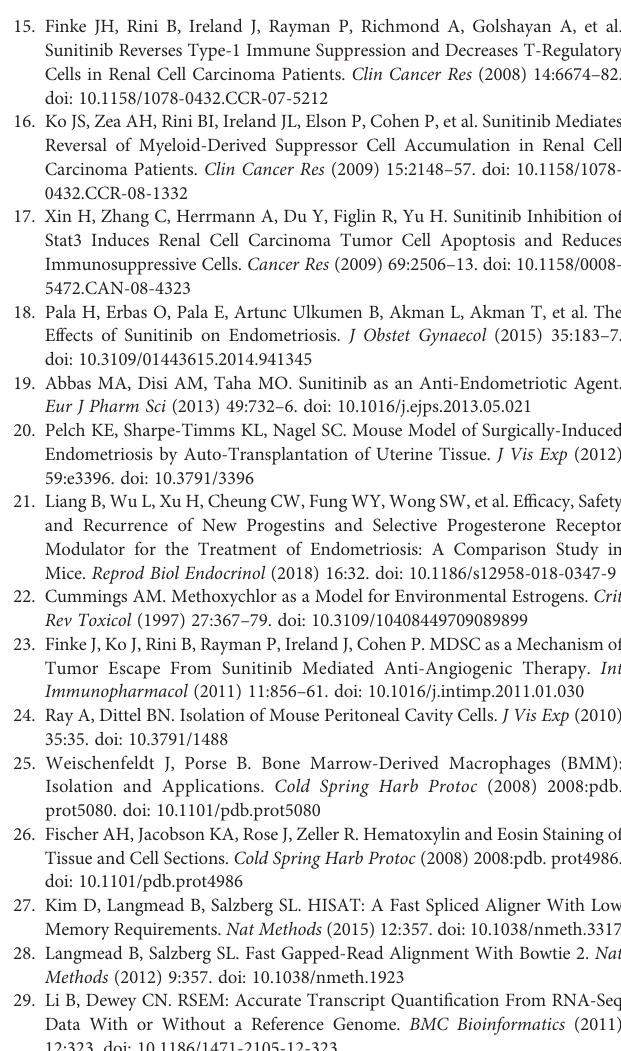
Supplementary Table 2 | Differential expression genes (DEG) of bone marrow G-MDSC. Supplementary Table 3 | Differential expression genes (DEG) of endometriotic